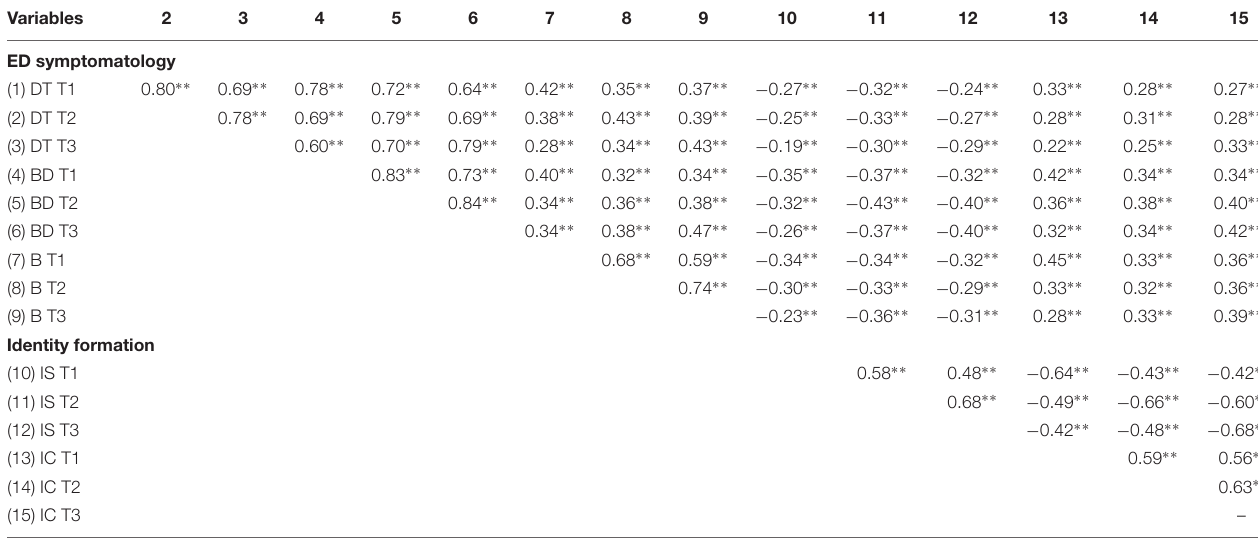
TABLE 2 | Correlations among the study